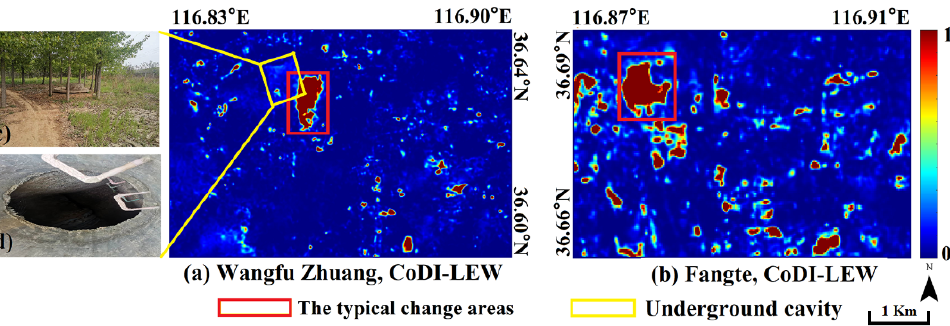
Figure 5. CoDI-LEWs of ( a ) Wangfu Zhuang Station and ( b ) Fangte Station. Note: the CoDI-LEWs are combined by the DVDI, MVDI and CDI with local energy weights. ( c , d ) Underground cavity around Wangfu Village.